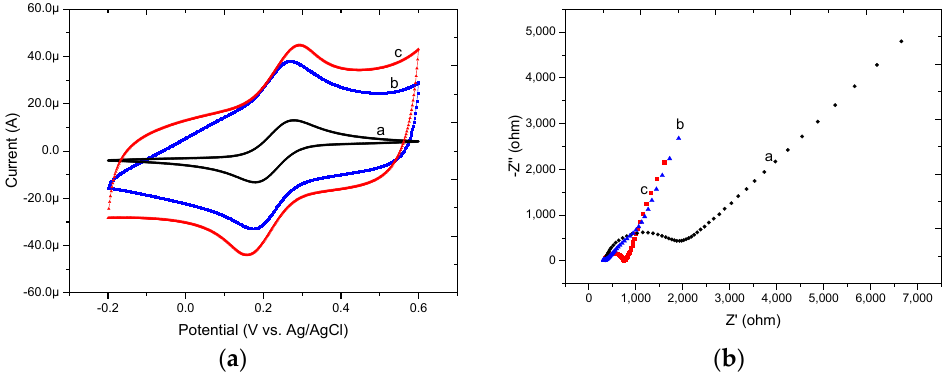
Figure 3. ( a ) Cyclic voltammetry (CV); and ( b ) electrochemical impedance spectroscopy (EIS) spectrums of bare Au (curve a), PPy/Au (curve b), and PPy/MWCNT/Au (curve c) microelectrodes in 5 mM [Fe(CN) 6 ] 3 − /[Fe(CN) 6 ] 4 − containing 0.1 M KCl.